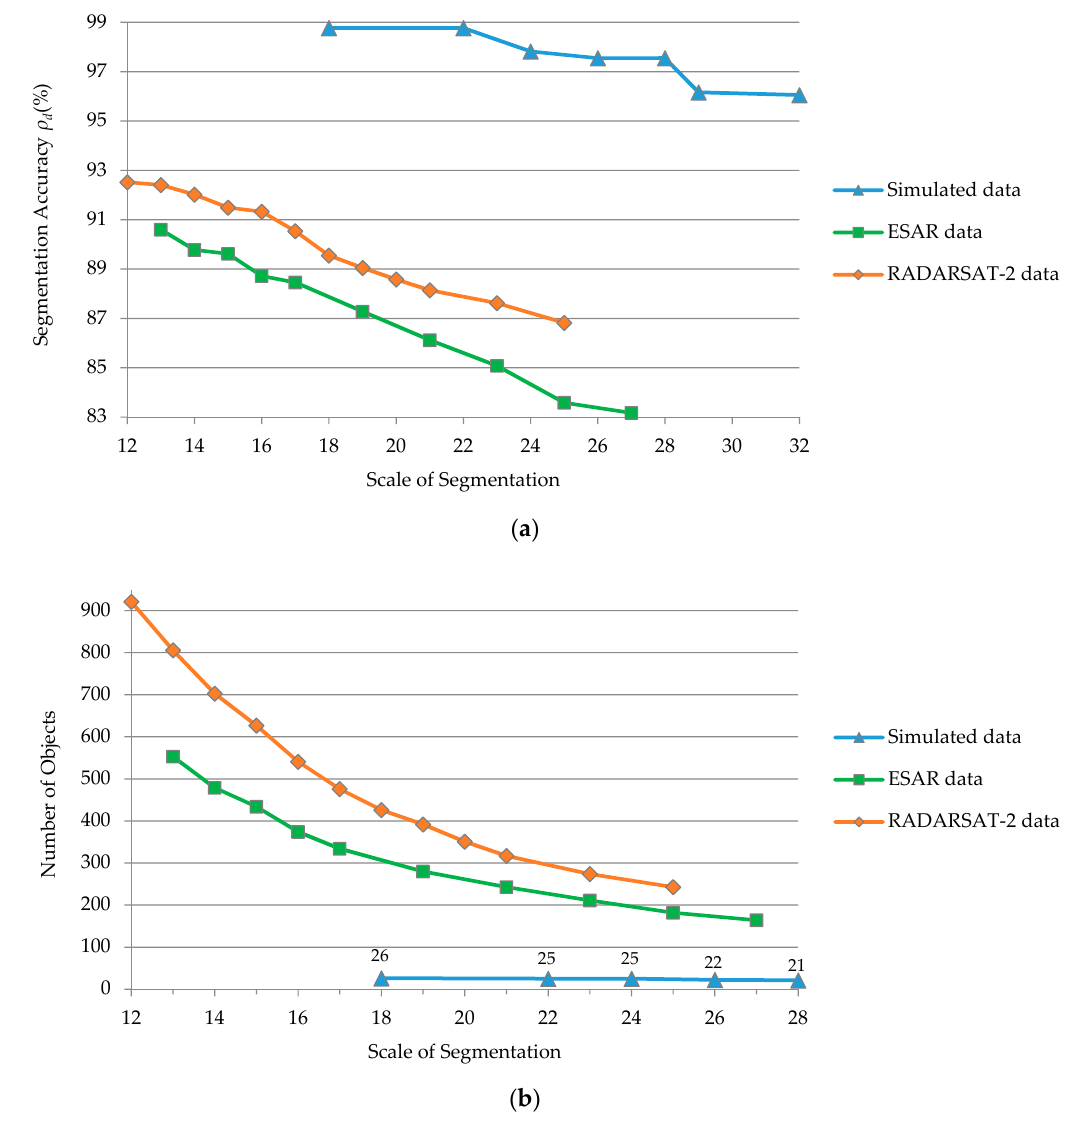
Figure 14. Segmentation accuracy obtained using the IFGS method for the simulated data, ESAR, and RADARSAT-2 data with different scales: ( a ) detection rate; ( b ) the number of result objects.